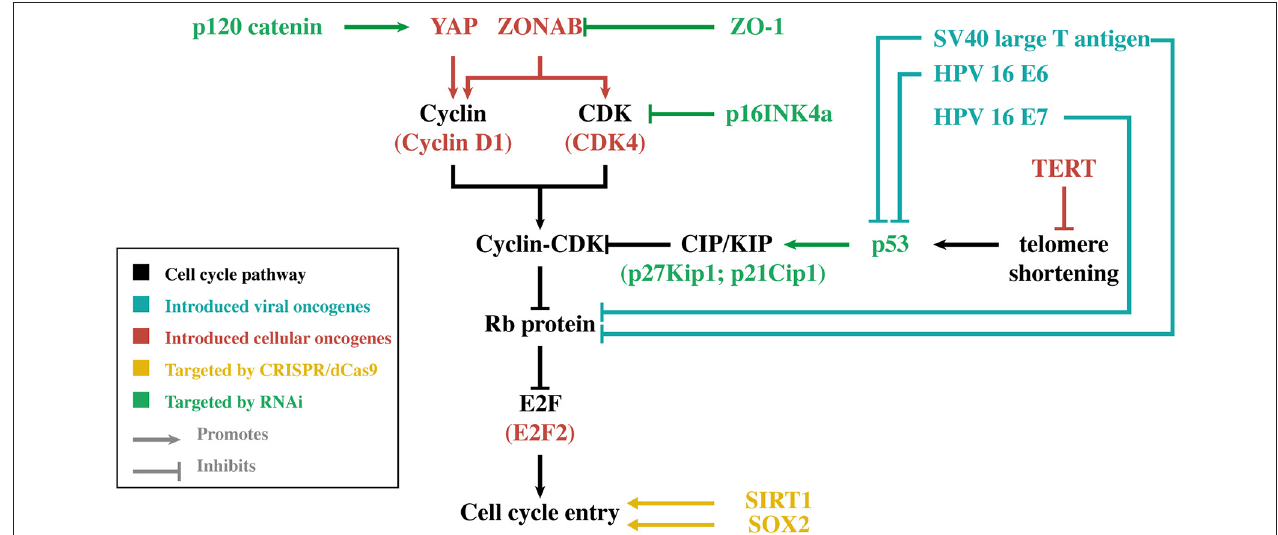
FIGURE 1 | Simplified overview of the main genes discussed in this review. For each gene, its relation to cell cycle entry is illustrated. The different colors indicate the genetic engineering strategy that was used to modify gene expression in human corneal endothelial cells. CDK, cyclin-dependent kinase; CRISPR, clustered regularly interspaced short palindromic repeats; dCas9, deactivated CRISPR-associated protein 9; HPV-16, human papilloma virus type 16; TERT, telomerase reverse transcriptase; Rb, retinoblastoma; RNAi, RNA interference; SOX2, sex-determining region Y-box 2; SV40, simian virus 40; YAP, Yes-associated protein.